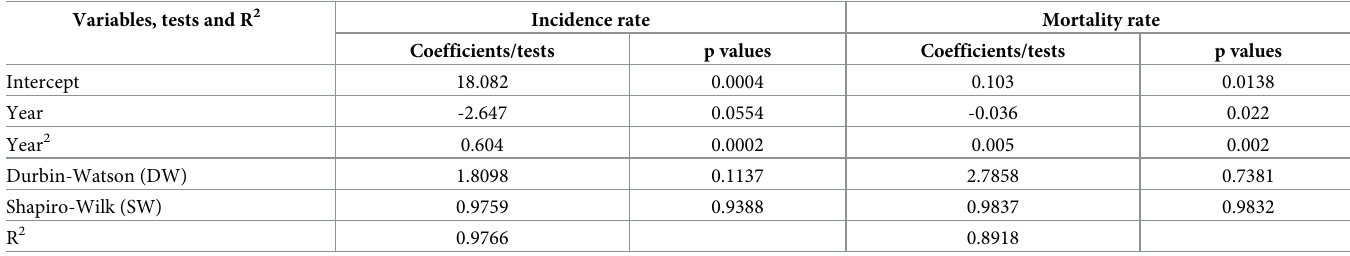
Table 2. Ordinary least squares quadratic regression models for temporal modeling of incidence and mortality rates for scorpion envenomations in the state of S ã o Paulo, Brazil from 2008 to 2018, and the results of the Durbin-Watson and Shapiro-Wilk